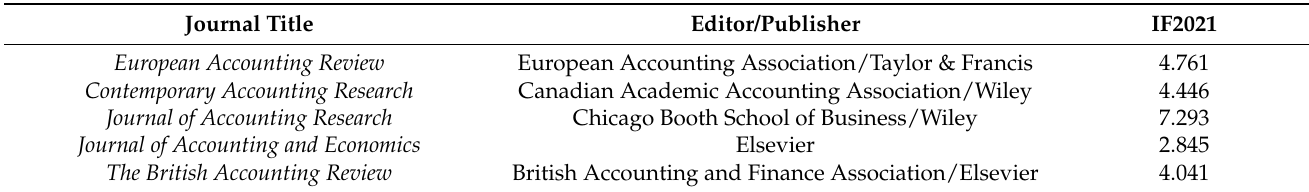
Table 1. Accounting journals examined in the paper for the period 2017–2021.